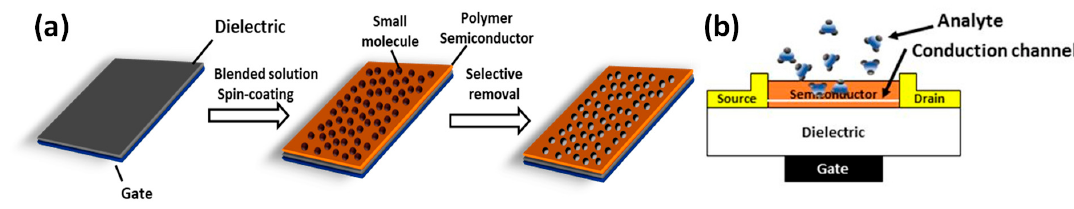
Figure 1. ( a ) Illustrative diagram presenting fabrication of morphology-controlled polymer films by selective dissolution of a small molecular component. ( b ) Schematic of chemical sensors based on the organic thin-film